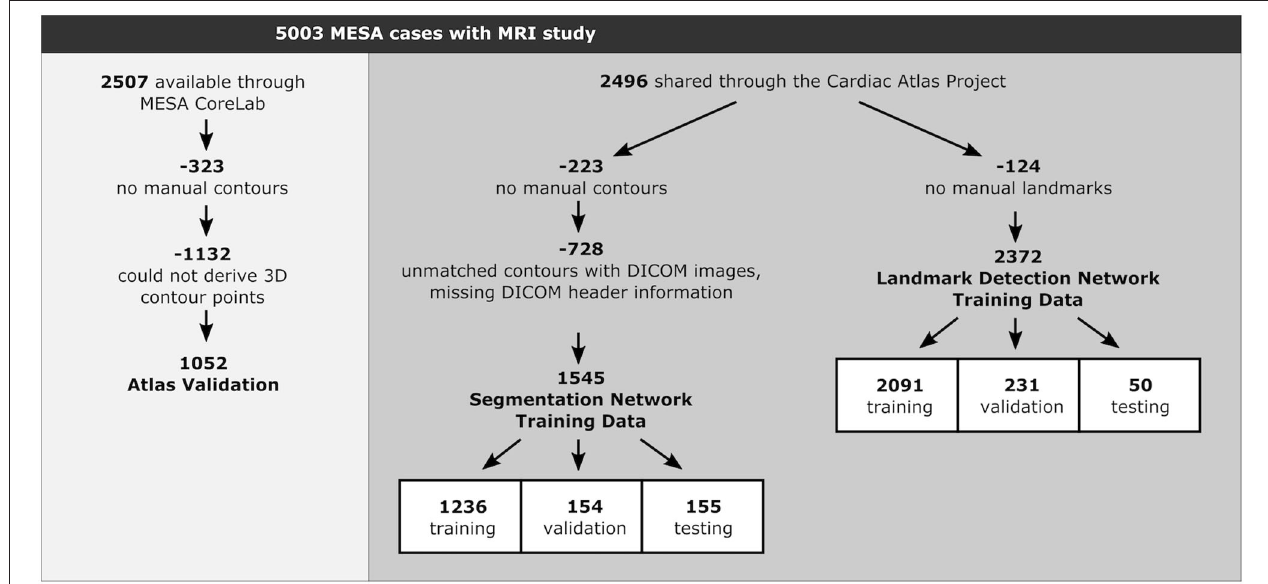
FIGURE 2 | Division of MESA cases into two independent sets of Atlas Validation and Training sub-cohorts. Within the Training sub-cohort, cases were divided into training, validation and testing sub-groups for the different deep learning networks (Segmentation Network and Landmark Detection Network).